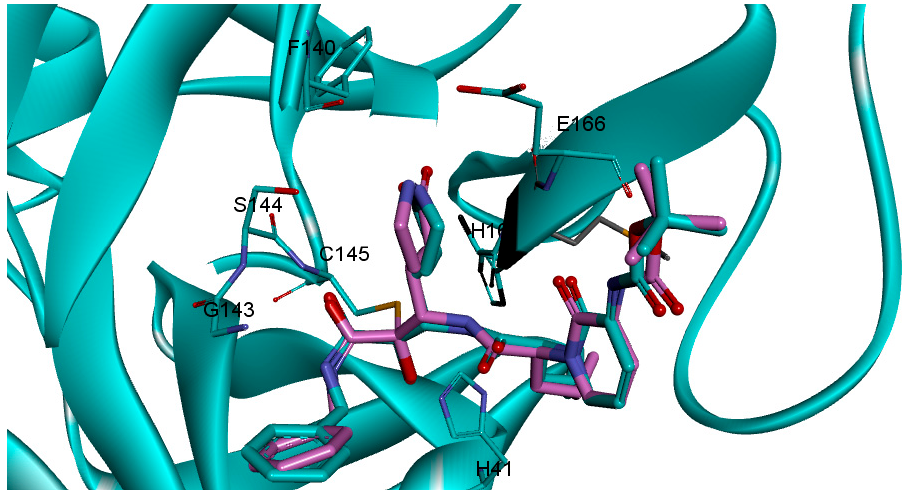
Figure 3. The re-docked pose (cyan) superimposed on the co-crystalized (pink). The docking results showed binding scores of − 7.1 and − 10.30 for O6K and RMH148, respectively, which indicates the potential for stronger binding and more interactions later with the COVID-19 Mpro. A closer look at the docked RMH148, as depicted in Figure 4, shows its engagement in a number of diverse interaction types within the binding site. For instance, RMH148 was able to make hydrogen-bond interactions with residues THR26, HIS41, TYR54, PHE140, GLY143, SER144, CYS145, HIS164 and GLU166, in addition to a